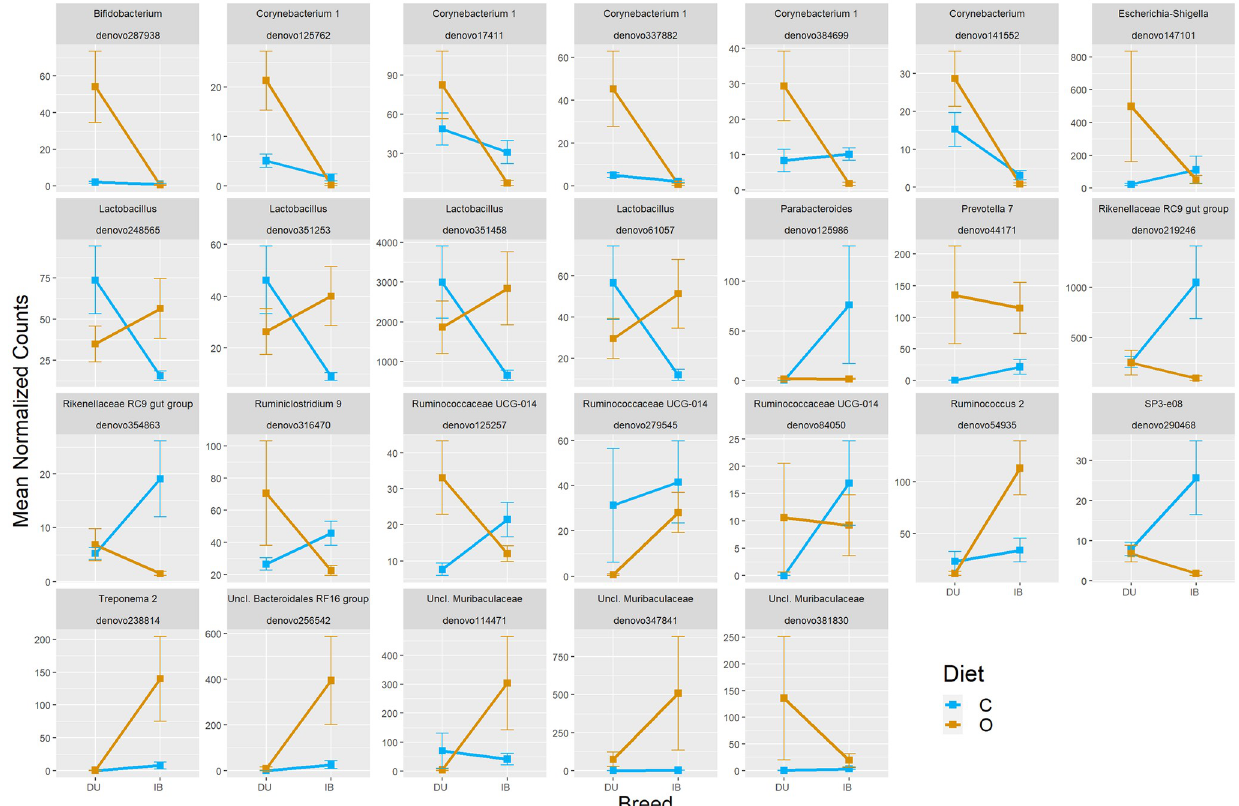
Fig 6. DA interaction plots (DESeq2). Interaction plots for each OTU with significant interaction between breed and diet factors for DA analysis with DESeq2. Normalized counts from DESeq2 algorithm and standard error of the mean (SEM) are represented in y-axis.